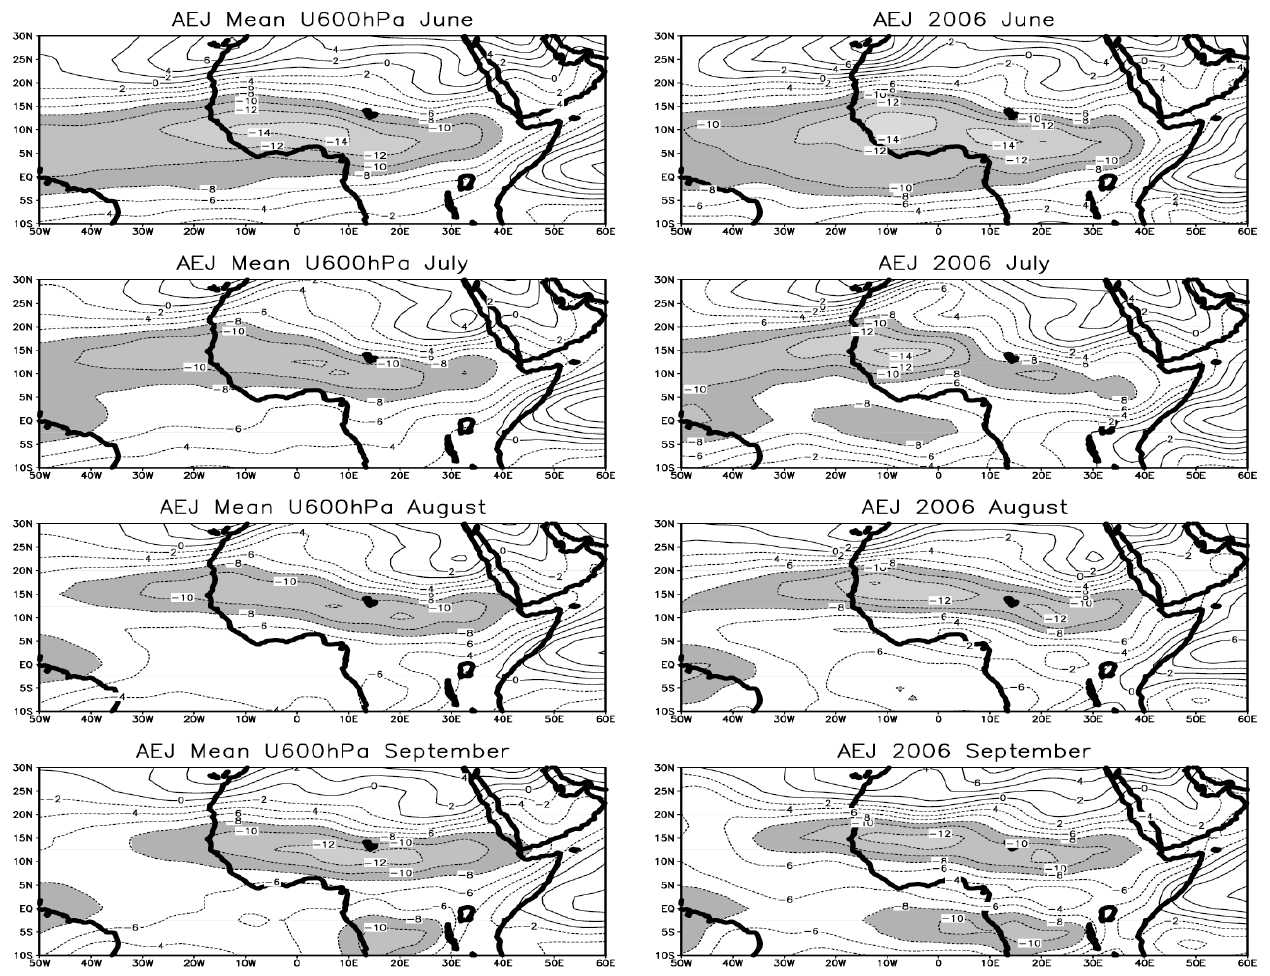
Figure 4. Left. 1979-1999 averaged zonal wind fields at 600 hPa, in June, July, August, September from NCEP. Right. Same wind fields but for 2006. Shaded areas for easterly wind component higher than 8 ms -1 .